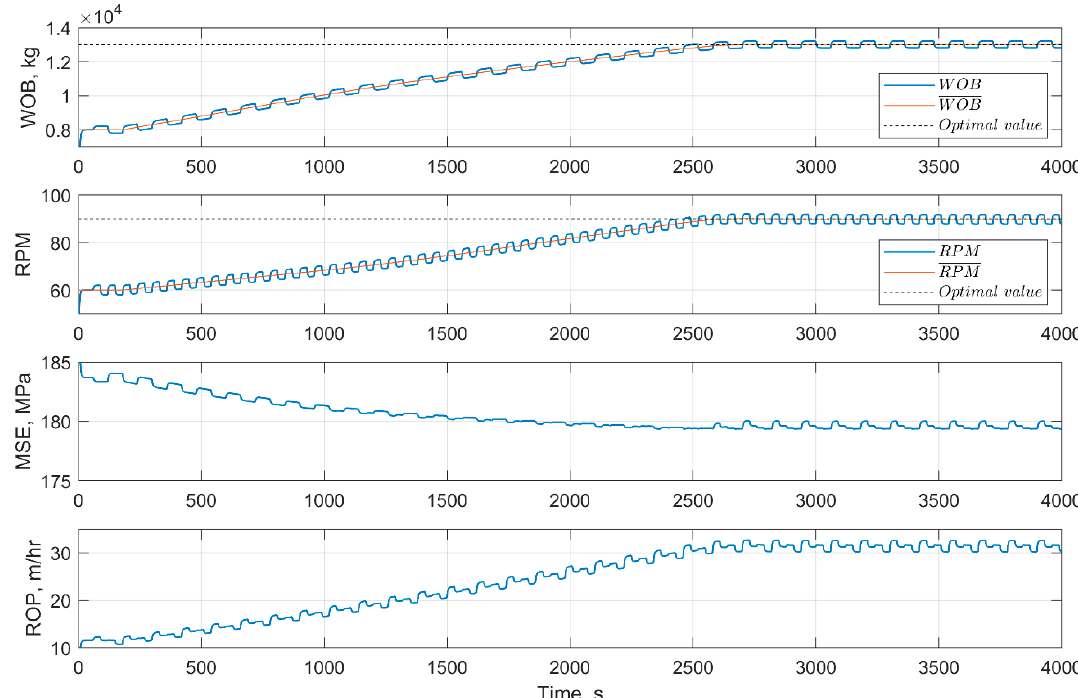
Figure 10. Simulation run 1, showing the ES algorithm converge to the optimum in the homogeneous formation A . The optimal WOB and RPM values indicated by the dotted lines are shown as an illustration and are not known by the ES algorithm.